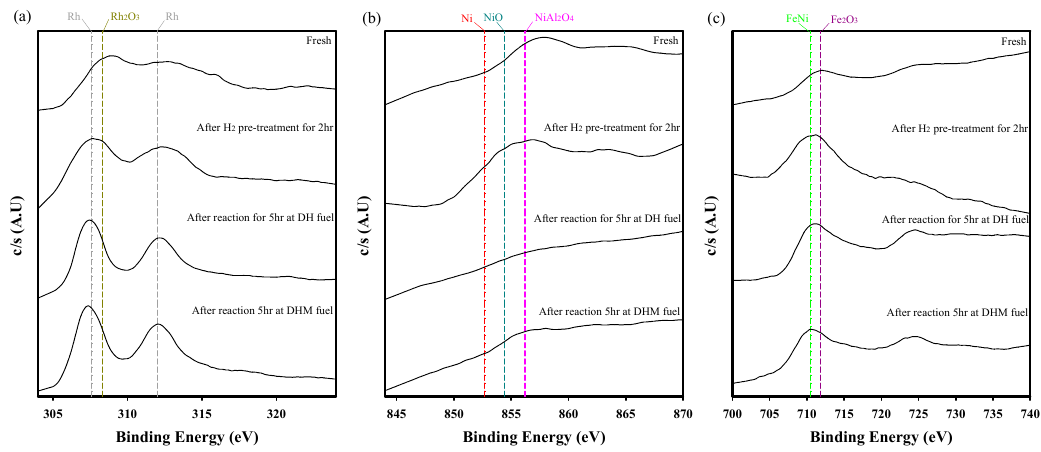
Figure 5. Results of XPS analysis performed on ( a ) R5A-I, ( b ) N10A, and ( c ) F10N10A.